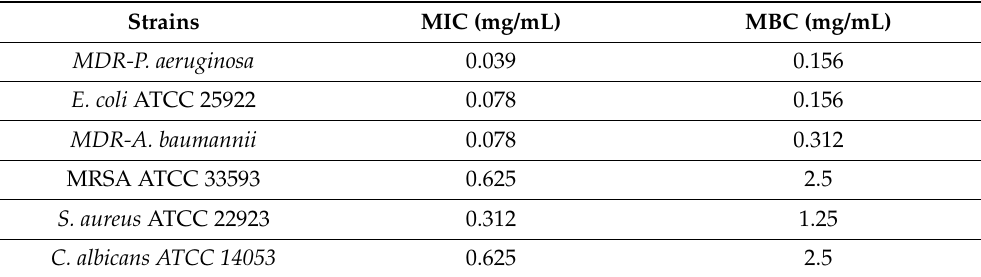
Table 2. MIC, MBC and MFC (mg/mL) values of AP-AgNPs tested against various strains. Strains MIC (mg/mL) MBC (mg/mL) MDR-P. aeruginosa 0.039